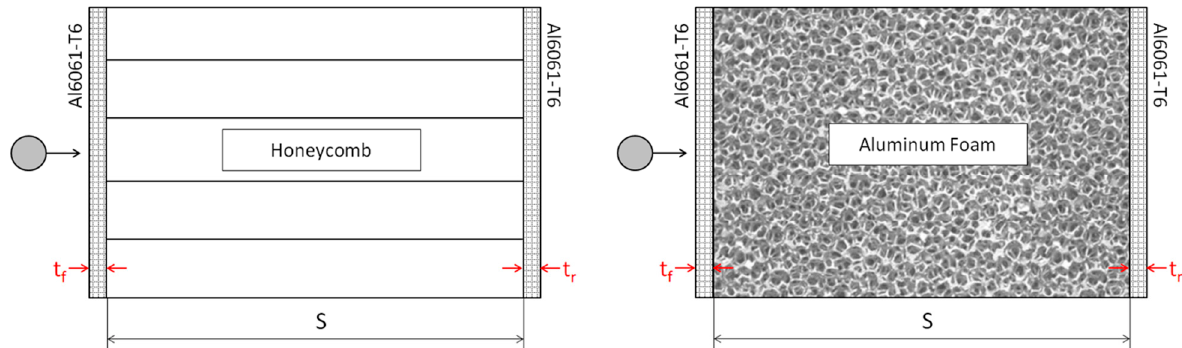
Figure 1. Schematic of single honeycomb ‐ core (left) and foam ‐ core (right) panels.